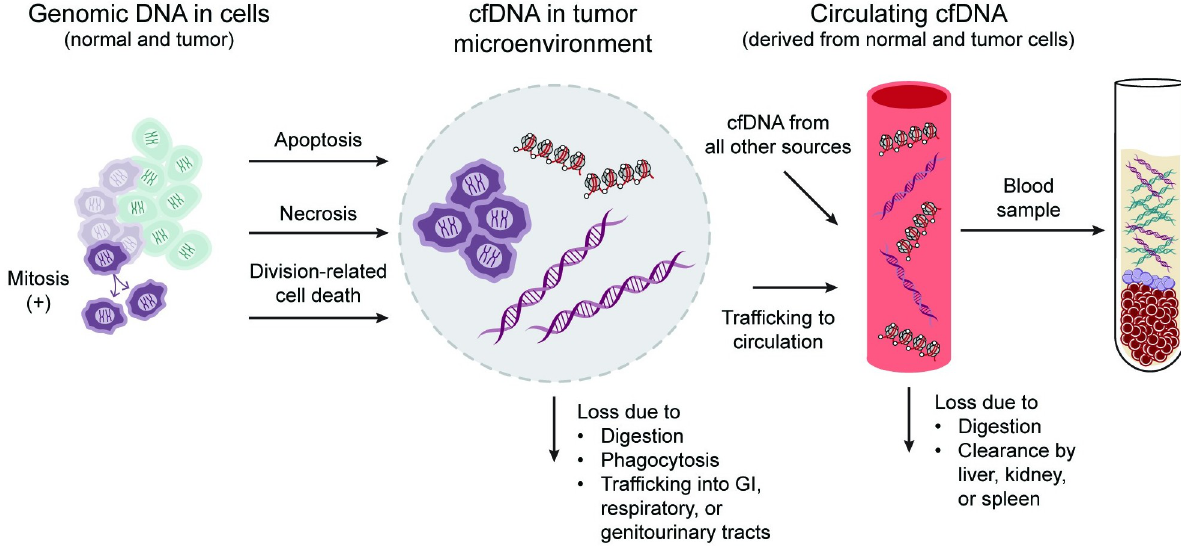
Fig 1. Depiction of origin and fates of circulating tumor DNA relative to cell-free DNA. Origin and fates of cfDNA influence the amount of ctDNA in a blood sample. Both normal cells (light green) and tumor cells (light purple) can shed DNA during cell death (e.g., by apoptosis or necrosis) [14–16]. In cancer, tumor cell mitoses and tumor growth increase the amount of DNA that can be shed into the tumor microenvironment (TME) [17]. In the TME, cfDNA has several fates: it may be digested [18, 19]; phagocytosed [17, 21]; lost into the lumen of the gastrointestinal, pulmonary, or genitourinary tract [22]; or trafficked into circulation where it is pooled with cfDNA from other cells in the body [21, 23]. After entering circulation, cfDNA is subject to further digestion or clearance in the liver, kidney, or spleen [23]. As a result, cfDNA in a blood sample is composed of tumor and normal cell DNA that is shed by dying cells and has not been removed by various clearance mechanisms. cfDNA: cell-free DNA, ctDNA: circulating tumor DNA, TME: tumor